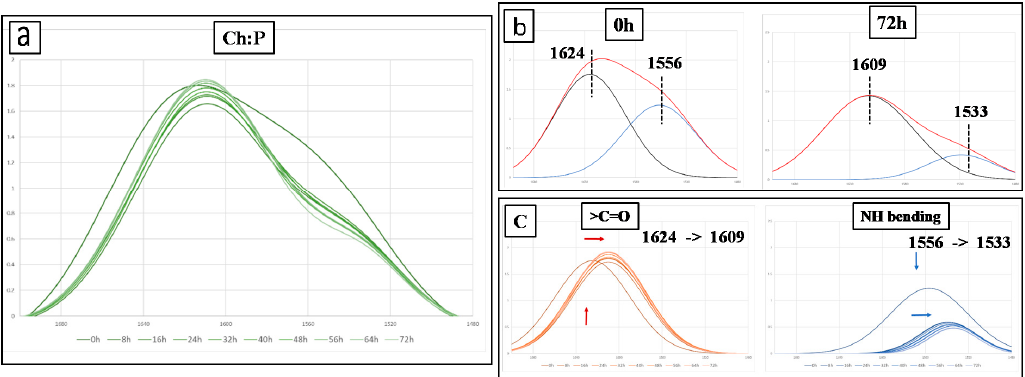
Figure 6. ( a ) Spectra in the range of 1700–1480 cm − 1 at different exposure times of the Ch:P blend, ( b ) deconvolution of the peaks of Ch:P before exposure and at maximum exposure time, and ( c ) trends for the two deconvoluted peaks at different exposure time.